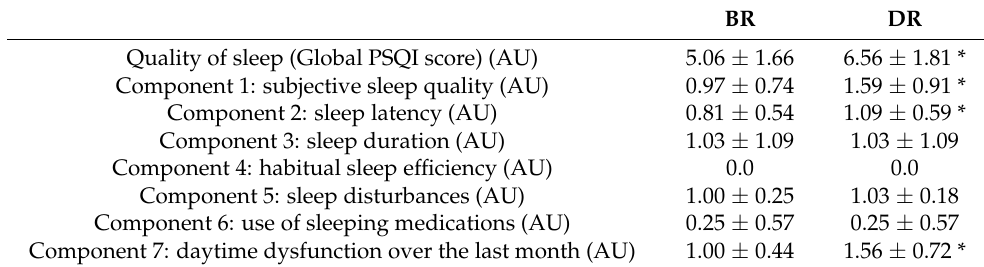
Table 2. Subjective sleep quality (mean ± SD) as estimated by the Pittsburgh Sleep Quality Index (PSQI). Values before (BR) and during (DR)